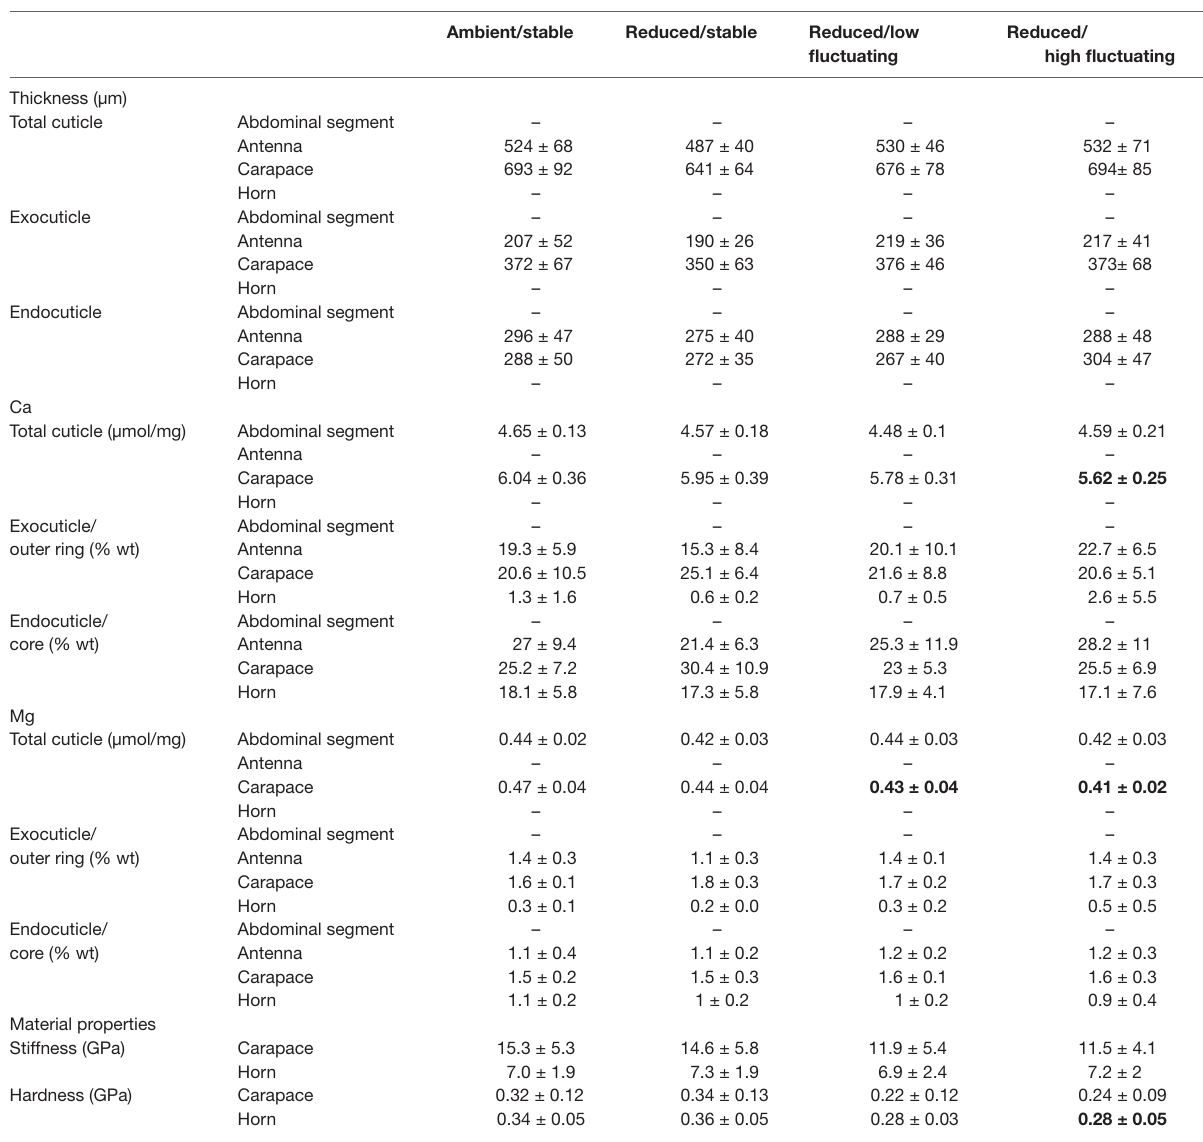
Values are mean ± s.d. Bold values are significantly different from values of lobsters in ambient